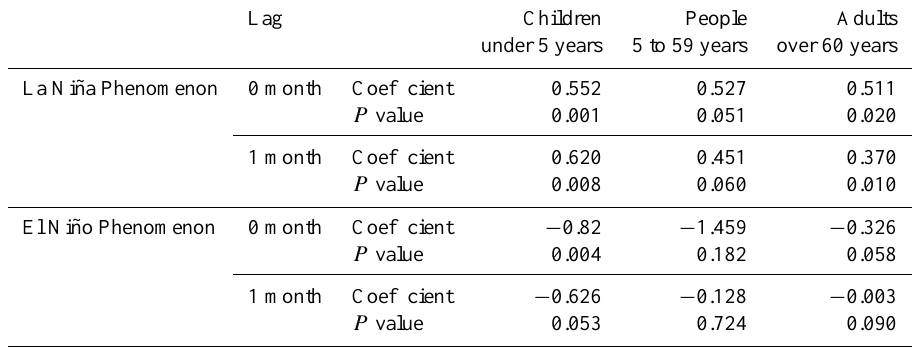
Table 3. Correlations between diarrhoea diseases and ONI in Aguascalientes from 2009 to 2010 after one heavy rain (2009) a strong drought (2010).